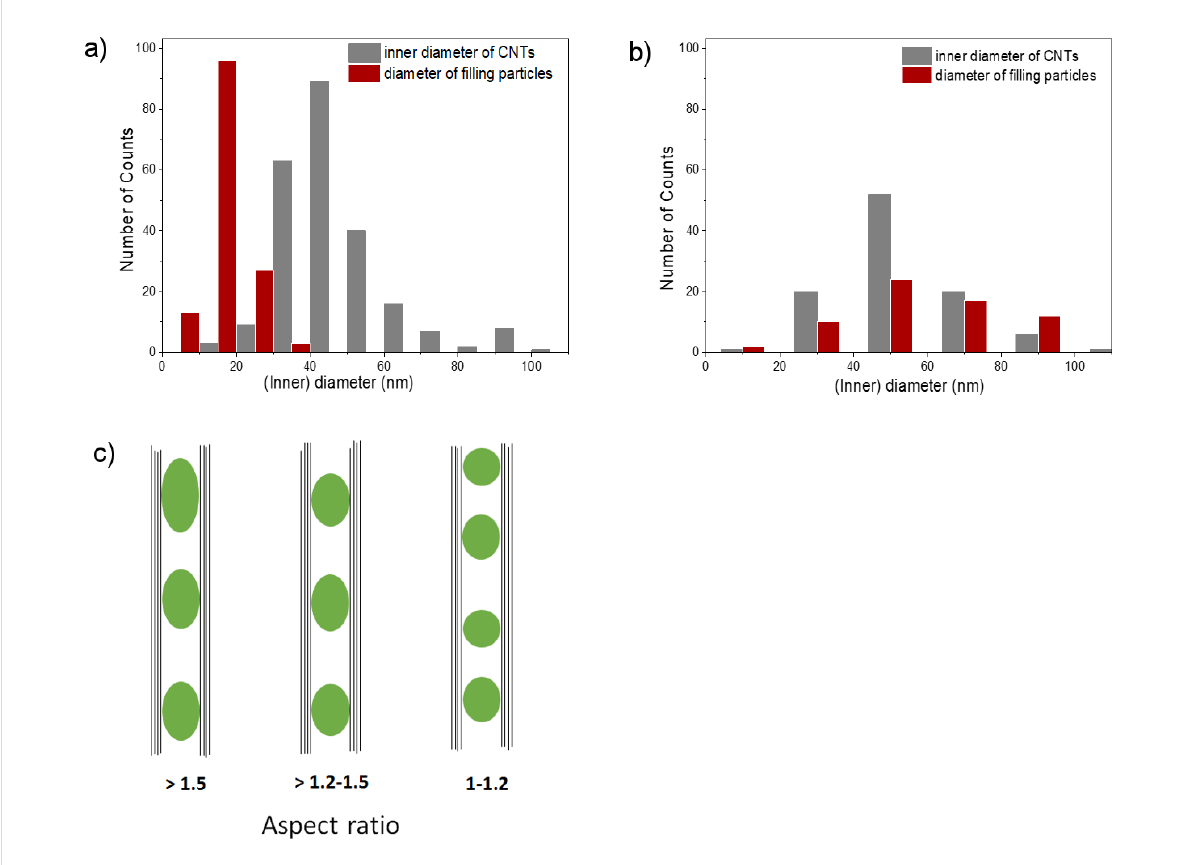
Figure 4: Histograms representing the distribution of the inner diameter (nm) of the CNTs and particle diameter for the a) as-prepared and b) annealed samples prepared by the second approach. c) Schematic representation of the geometry of the filling particles with respect to the aspect ratio